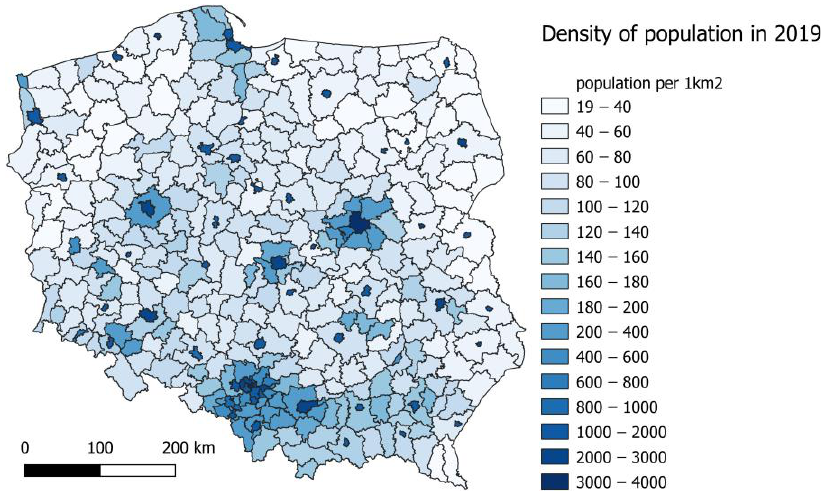
Figure 1. Population density per country in Poland in 2019.